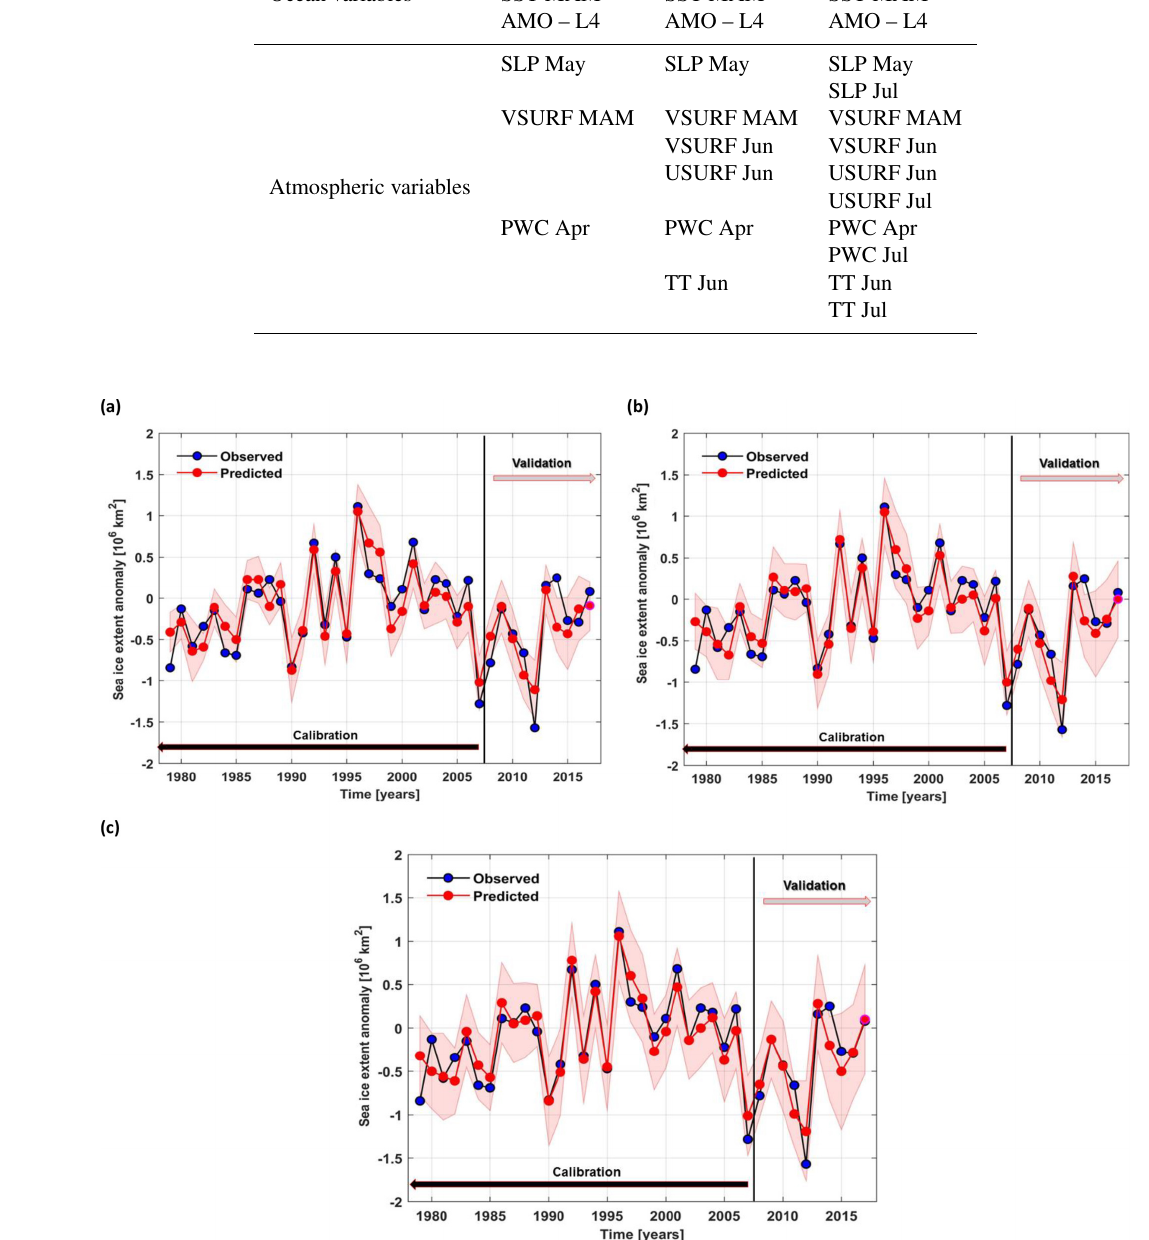
Figure 4. Observed (black) and predicted (red) September sea ice extent detrended anomalies over the period 1979–2017 based on (a) May, (b) June and (c) July predictors from the stable regions. The shaded area represents the 95% uncertainty bounds.